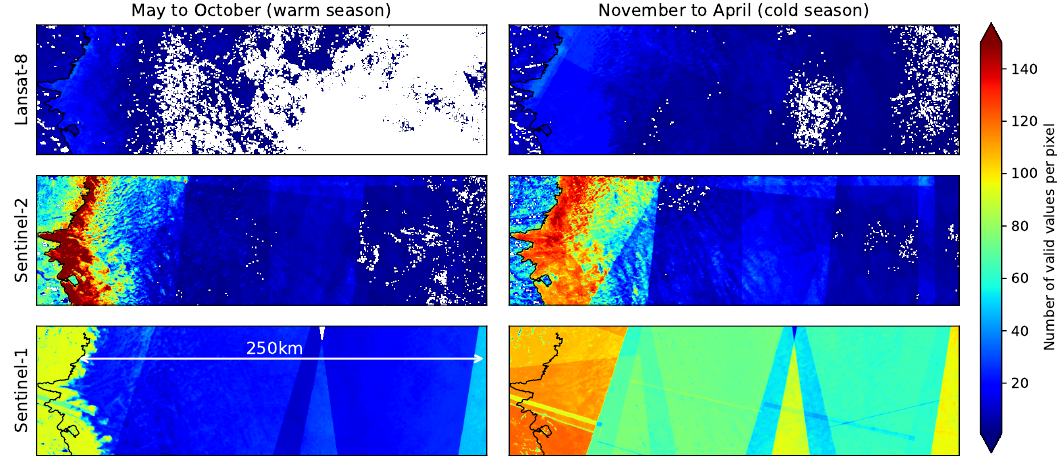
Figure 3. Number of valid speed estimates for year 2018 using Landsat-8, Sentinel-2, and Sentinel-1 sensors over the region of Russell Gletscher, West Greenland. White areas correspond to locations with no successful correlation between image pairs.